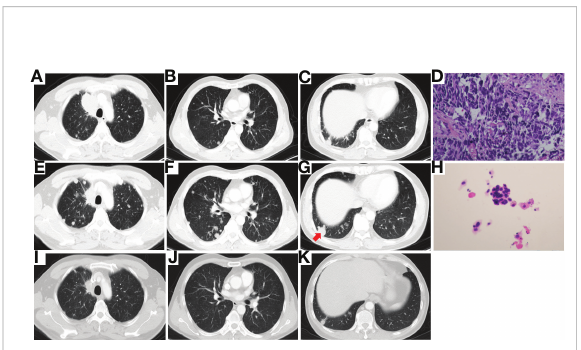
FIGURE 3 Chest CT scan of PD after 8 cycles of chemotherapy combined with PD-1 inhibitor (A – C) , photomicrograph of the third biopsy (H&E stain) showing SCLC transformation (D) , Chest CT scan after 2 cycles of EC chemotherapy showing the main lesion of RUL signi fi cantly shrank (E) , while intrapulmonary metastatic nodules increased and enlarged (F, G) , the pathology (H&E stain) of the enlarged metastatic lesion of RLL ( red arrow ) showing NSCLC (H) , and chest CT scan of PR after 2 cycles of combination therapy of osimertinib and EC chemotherapy (I – K) . CT, computed tomography; PD, progressive disease; PD-1, programmed cell death 1; SCLC, small cell lung cancer; EC, etoposide plus carboplatin; RUL, right upper lobe; RLL, right lower lobe; NSCLC, non-small cell lung cancer; PR, partial response.